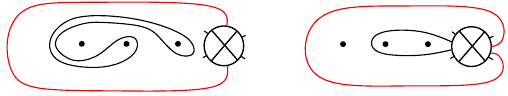
Figure 5. Two multicurves oin N 1,3 with R =